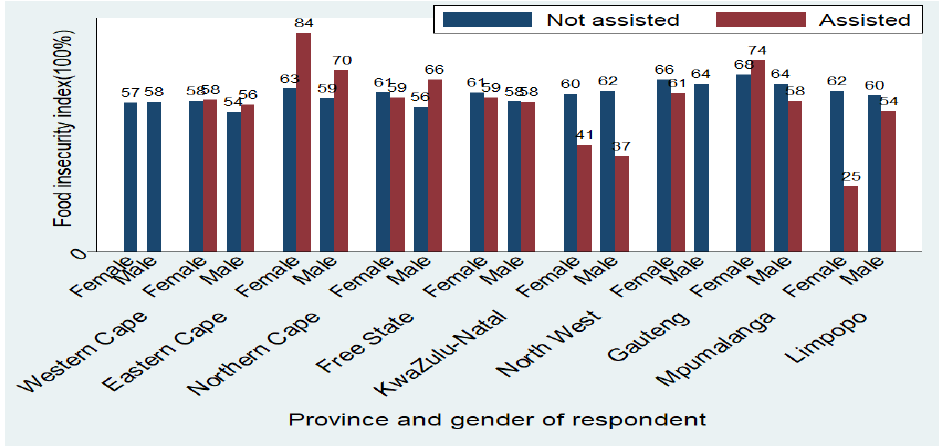
Figure 7. Food insecurity by province and assistance status of the respondent.